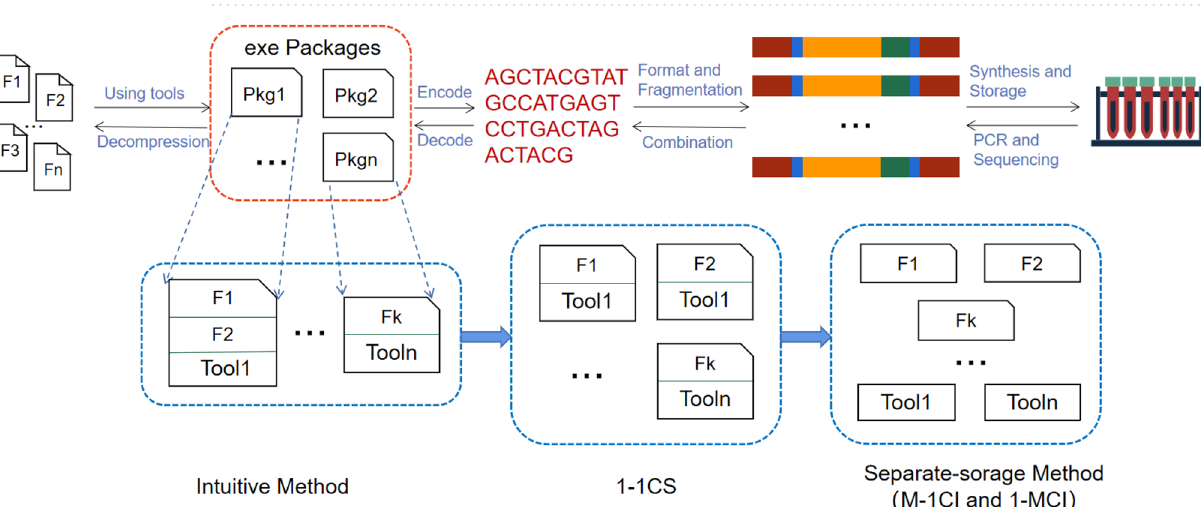
Figure 3. Storage process and three implementation methods: The general storage processing of DNA files is improved with the self-contained method. The red dashed box represents the design of file format while the first blue dashed box below represents intuitive method : combining the data files that adopt the same tool (e.g., using the same compression program) together. However, this method is not well suitable for DNA storage. The second blue dashed box indicates that each file is packaged separately which we call this method one-to-one continuous storage (1-1CS) method—the data and tools are stored together. In contrast, the third box represents discontinuous storage method where the tools and data are stored separately (separate-storage method), which is desired to minimise the data